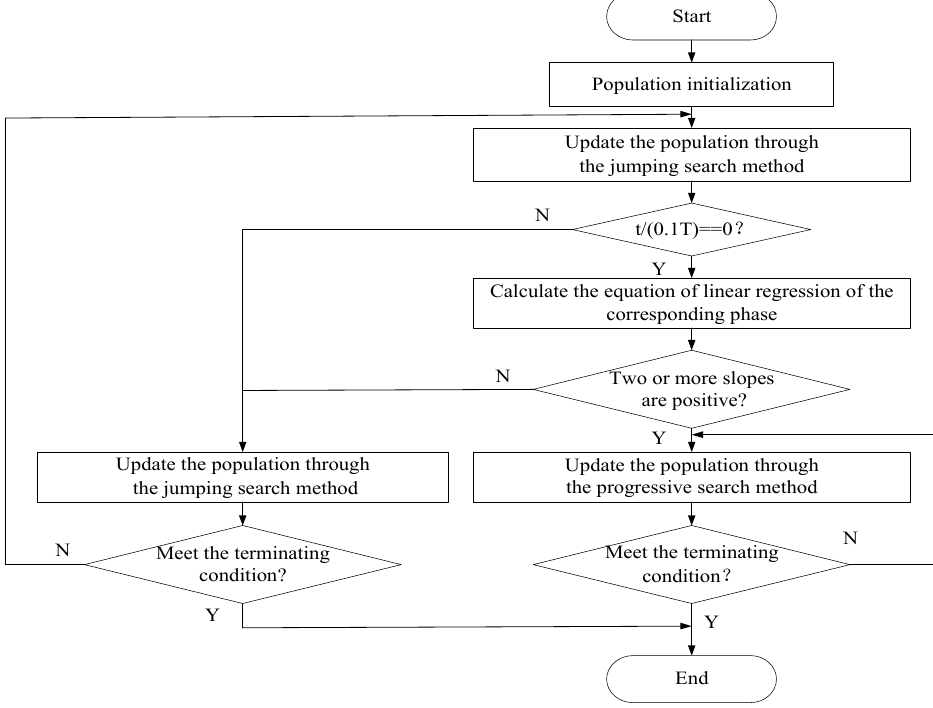
Figure 3. The procedure of improved squirrel search algorithm (ISSA).